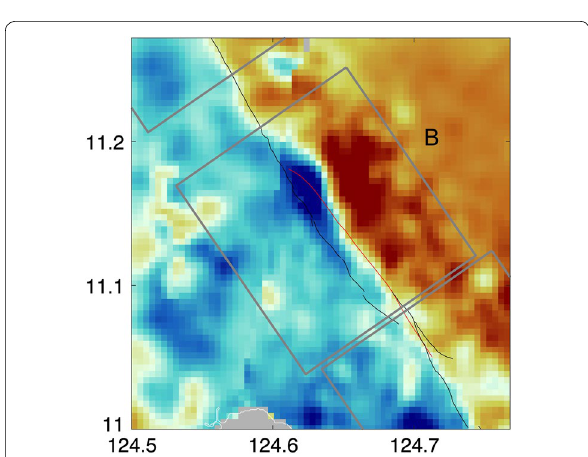
Fig. 10 Close-up figure of the fault-parallel horizontal velocity (Fig. 6a) around a latitude range of 11.0–11.2 ◦ N. Same colorscale as Fig. 6a is used